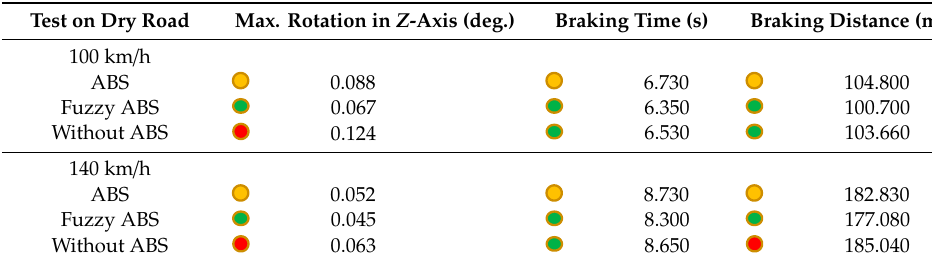
Table 9. Comparison of parameters when braking on dry road.